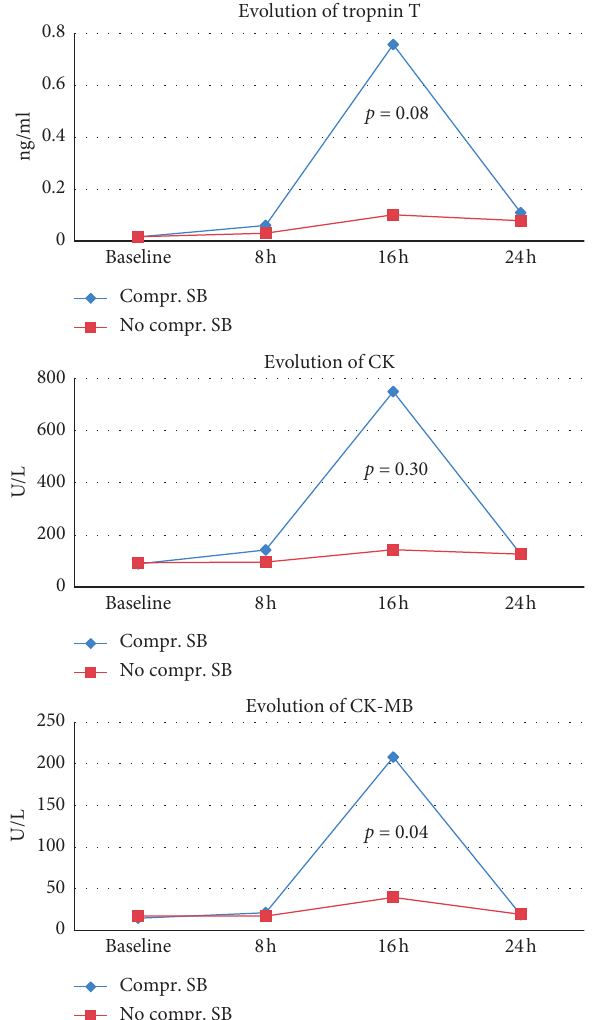
Figure 2: Evolution of median value of cardiac biomarkers in patients with ( n � 20) and without ( n � 84) compromised side branch at the end of the